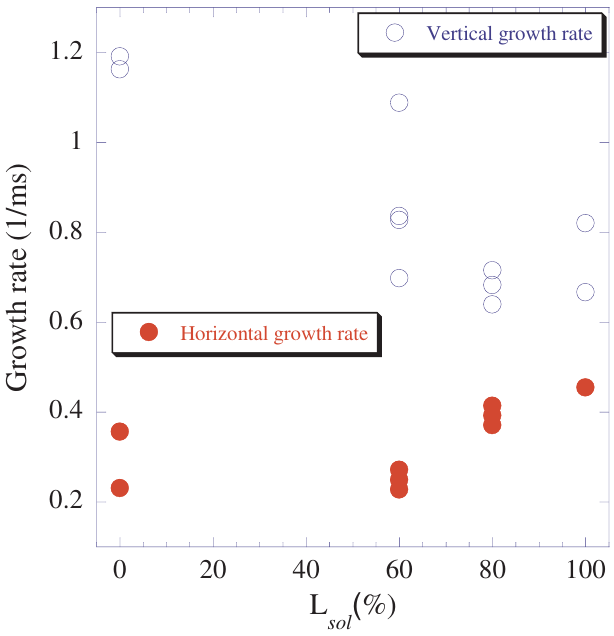
FIG. 15. (Color) Horizontal (solid circle) and vertical (open circle) growth rates of the instability with different L chromaticities ranged over 0 : 797 (cid:5) 3 : 06 and 1 : 4 (cid:5) 3 : 3 for the horizontal and vertical planes, respectively.